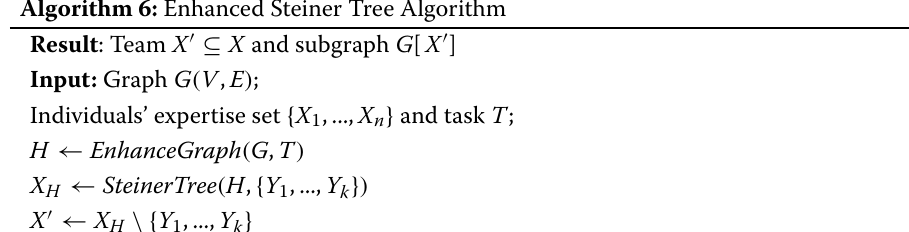
Algorithm 6: Enhanced Steiner Tree Algorithm